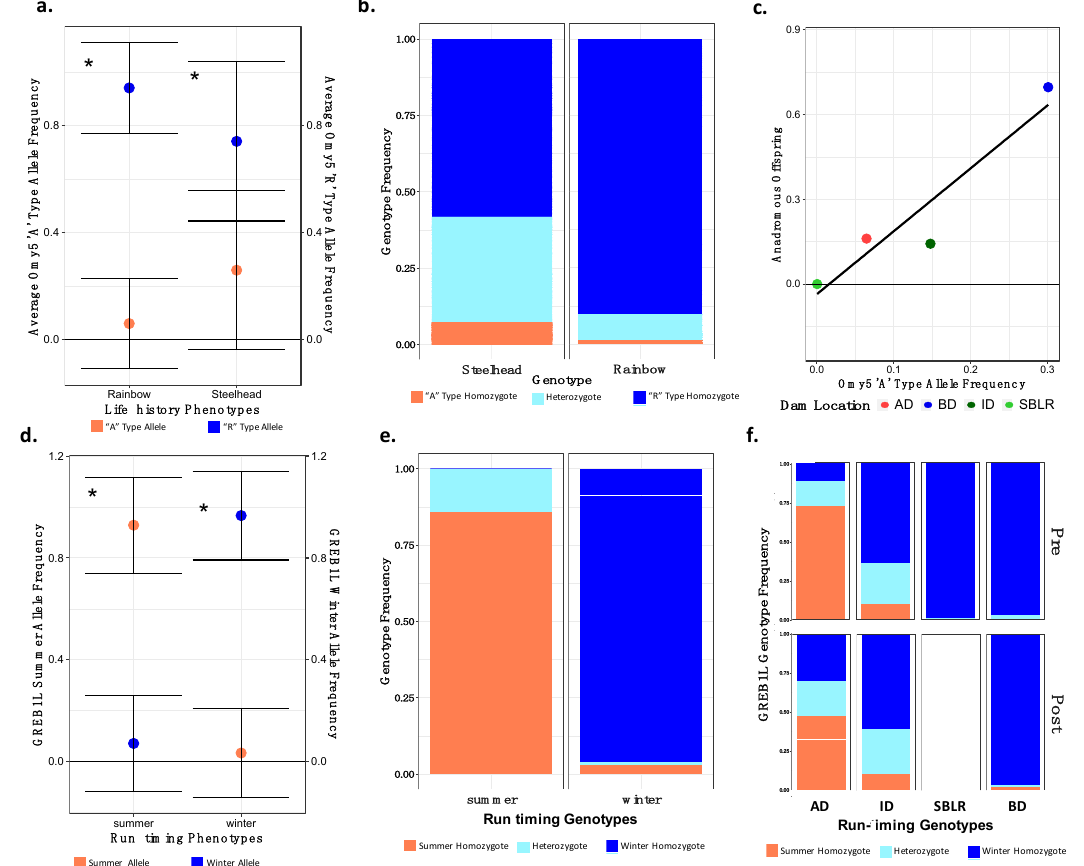
Figure 7. There were significant differences in the allelic and genotypic frequencies of the Omy5 ( a–c ) and the GREB1L variants ( d–f ) among populations and life histories. There were significant differences in the mean allele frequencies of the Omy5 locus allele frequencies between steelhead and unknown forms ( a ) and the frequency of the Omy5 “A” type allele frequency significantly explained life history phenotype ( b ). We also observed a strong correlation between the number of anadromous individuals from each population and the frequency of the “A” allele ( c ). The mean frequency of the GREB1L summer allele also varied significantly between summer- and winter-run steelhead ( d ), with the frequency of the homozygous summer genotype significantly explaining run timing ( e ), and inferred, ancestral population explaining a significant proportion of the variation in genotype both prior to and post-dam removal ( f ). Asterisks ( a,c ) indicate statistical significance ( α = 0.01) (*).